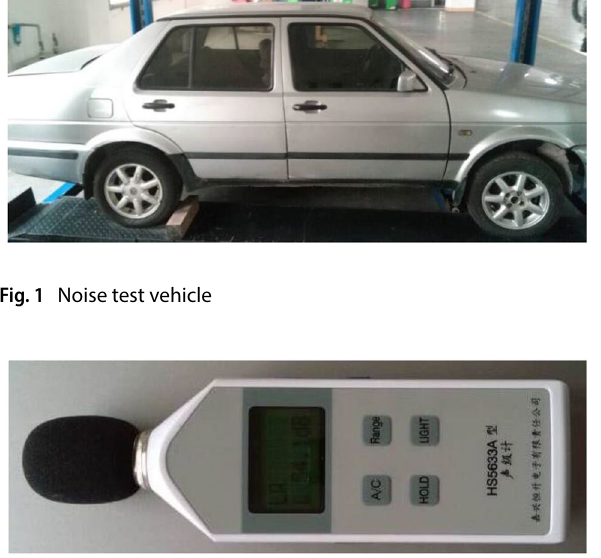
Fig. 2 Noise test digital sound level